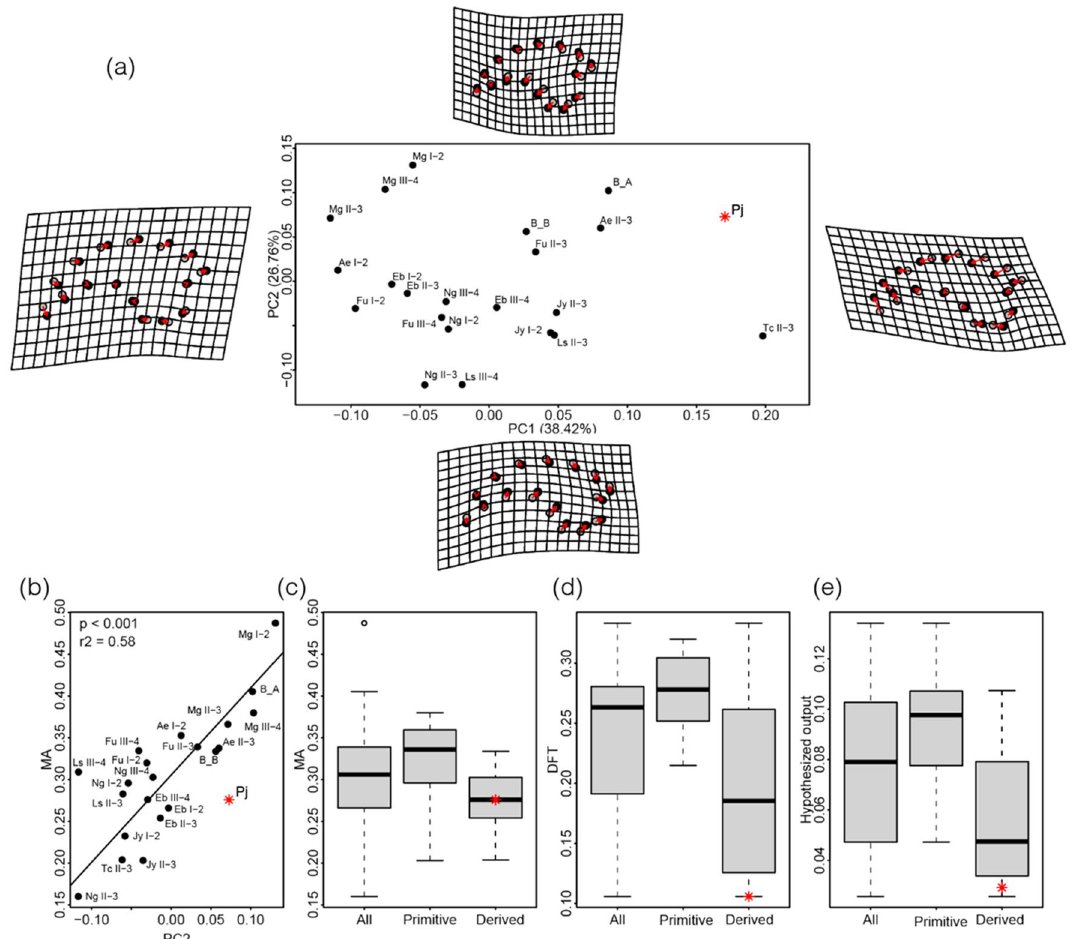
Figure 7. ( a ) Scatter plot showing the PC1 and PC2 values obtained from the geometric morphometric analysis. The grey dots on the thin plate spline 26 represent the “average” positions of the landmarks and the black dots represent the positions after deformation. ( b ) Regression plot of PC2 values obtained from the geometric morphometric analysis and the mechanical advantage of the therizinosauroid unguals. Boxplots showing the ( c ) mechanical advantages, ( d ) development of flexor tubercle, and ( e ) hypothesized output force among therizinosauroids. The red star represents Paralitherizinosaurus japonicus in all plots.